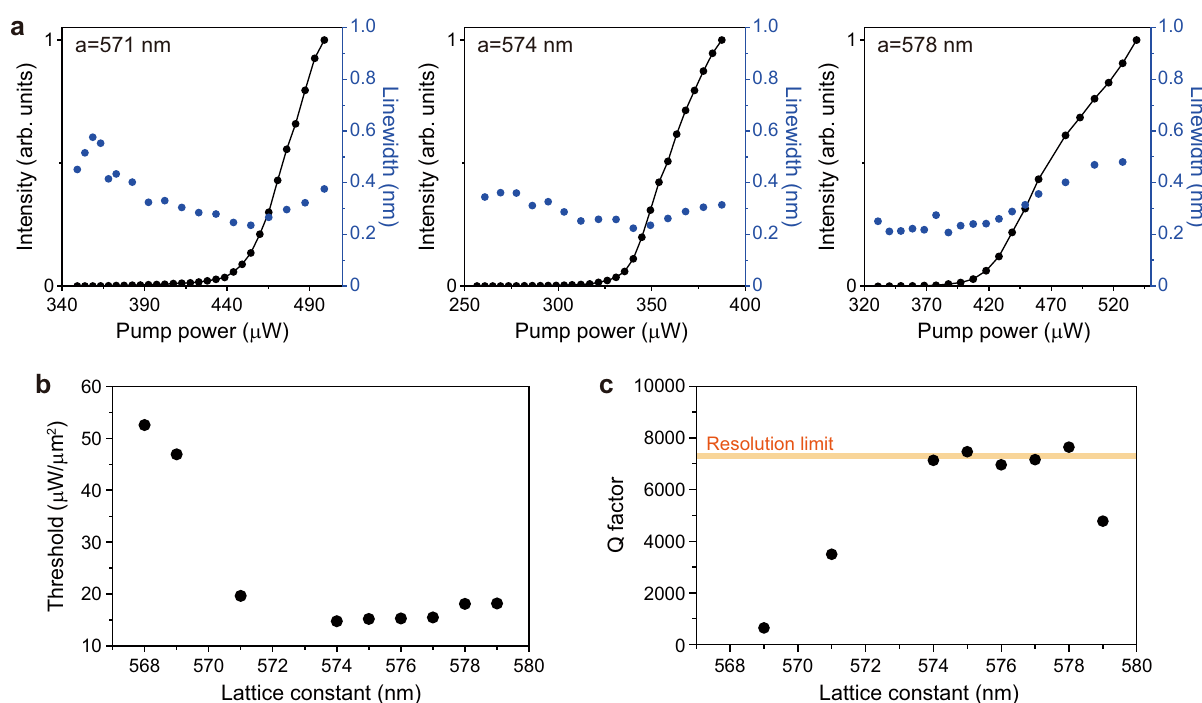
Fig. 4 Threshold and Q factors of BIC lasers. a Measured L – L curves (black; left y -axis) and linewidth (blue; right y -axis) of the symmetry-protected BIC lasers at a = 571 nm, 574 nm, and 578 nm. The increase of the linewidth above the threshold is due to the thermal effect. b Measured threshold values divided by the pump area (~5.4 μ m in size) as a function of the lattice constant. c Measured Q factors, λ / Δλ , as a function of the lattice constant. Δλ is the linewidth estimated at the transparent pumping condition (~340 μ W). The linewidth data were taken from Supplementary Fig. 10. The orange line indicates the Q factor obtained using the resolution-limited linewidth of the spectrometer (~0.22